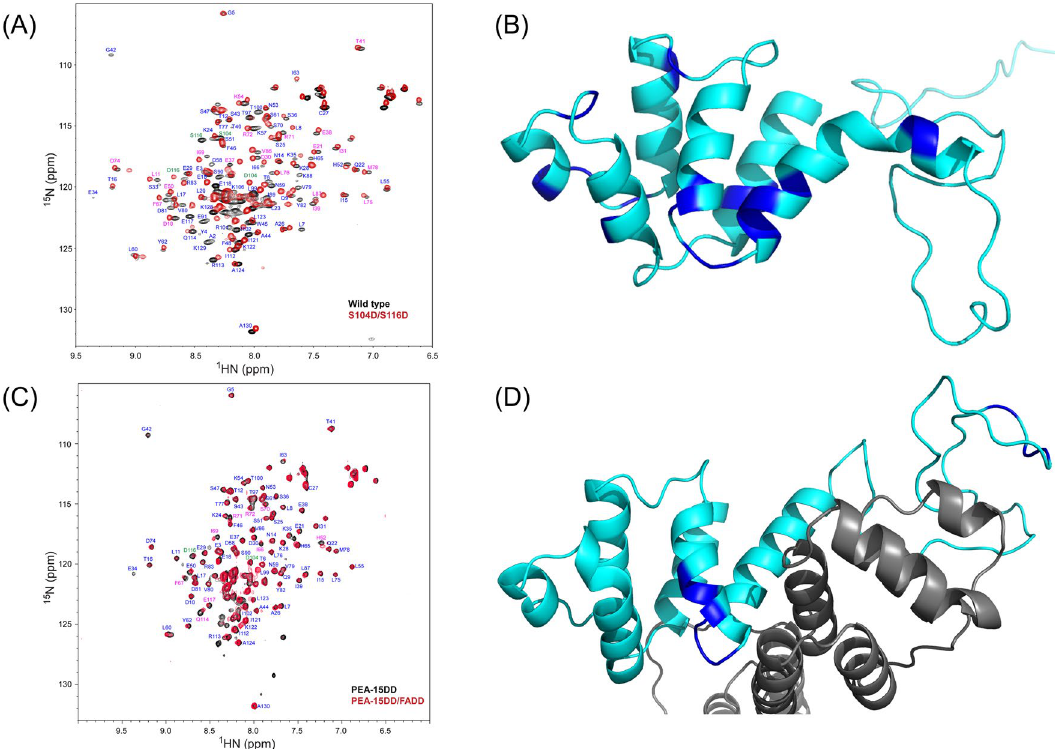
Figure 6. ( A ) Partial assignment of 2D HSQC 1 H– 15 N correlation spectrum of PEA-15DD double mutant (red) overlaid with wild-type PEA-15 (black) spectrum. The assigned resonances are labeled next to the corresponding peaks. The resonances for wild-type S104 and S116 and the mutants S104D and S116D are labeled in green, the resonances experiencing significant chemical shift perturbation (CSP) upon mutation are labeled in magenta, and other resonances not shifted by mutation are labeled in blue. ( B ) Residues that experience significant CSP upon double mutation/double phosphorylation are mapped on the simulated PEA- 15pp structure (cyan) and colored in blue. These residues include residues from helices α3, α5, and α6, as well as residues after the kink at the end of helix α6. ( C ) Partial assignment of 2D HSQC 1 H– 15 N correlation spectra of PEA-15DD in its free form (black) and FADD-bound form (red). The available assignment for each resonance is labeled next to the peak. The two mutation sites, S104D and S116D, are labeled in green, the resonances experiencing significant CSP upon FADD binding are labeled in magenta, and other resonances not shifted by FADD binding are labeled in blue. ( D ) Residues that experience significant CSP on PEA-15DD (cyan) upon FADD binding are mapped on the simulated PEA-15pp/FADD structure and colored in blue. These residues are mostly from α5/α6 surface engaging in FADD binding. FADD is colored in grey. The NMR spectra in ( A ) and ( C ) were plotted using NMRViewJ version 9.2 (https:// nmrfx. org/ nmrfx/ nmrvi ewj), and the molecular structures in ( B ) and ( D ) were visualized and generated using PyMOL version 2.4 (http:// www. pymol.